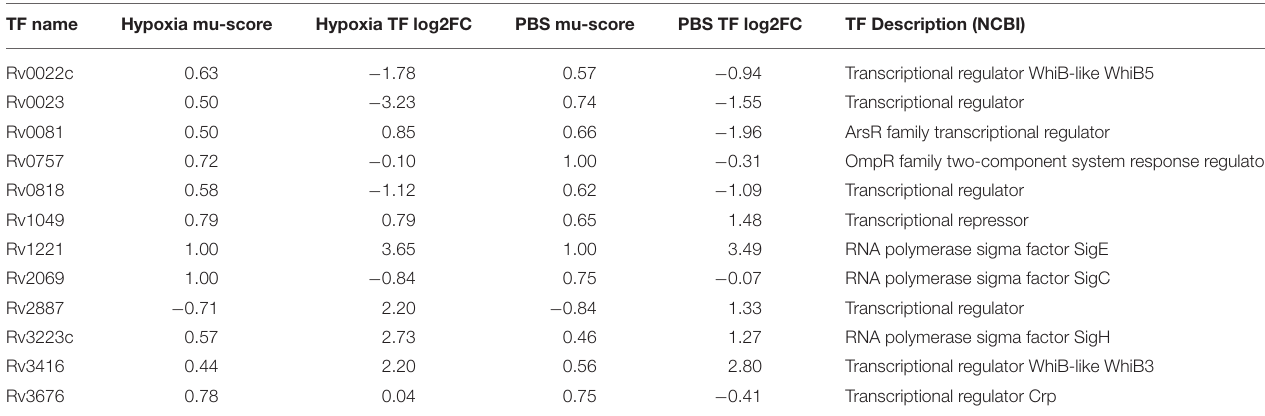
TABLE 1 | Regulons showing significant enrichment using our collected RNA-seq